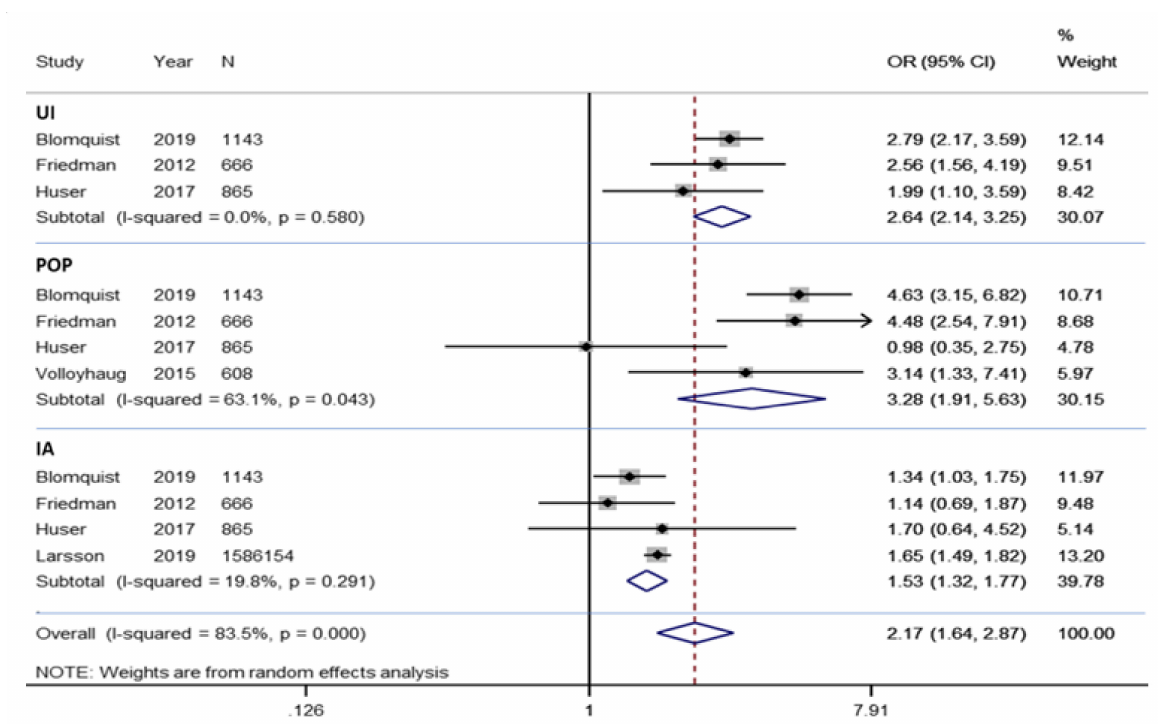
Figure 3. Forest plot for UI, POP, AI, overall in the Cesarean delivery and Vaginal delivery groups. OR, Odds